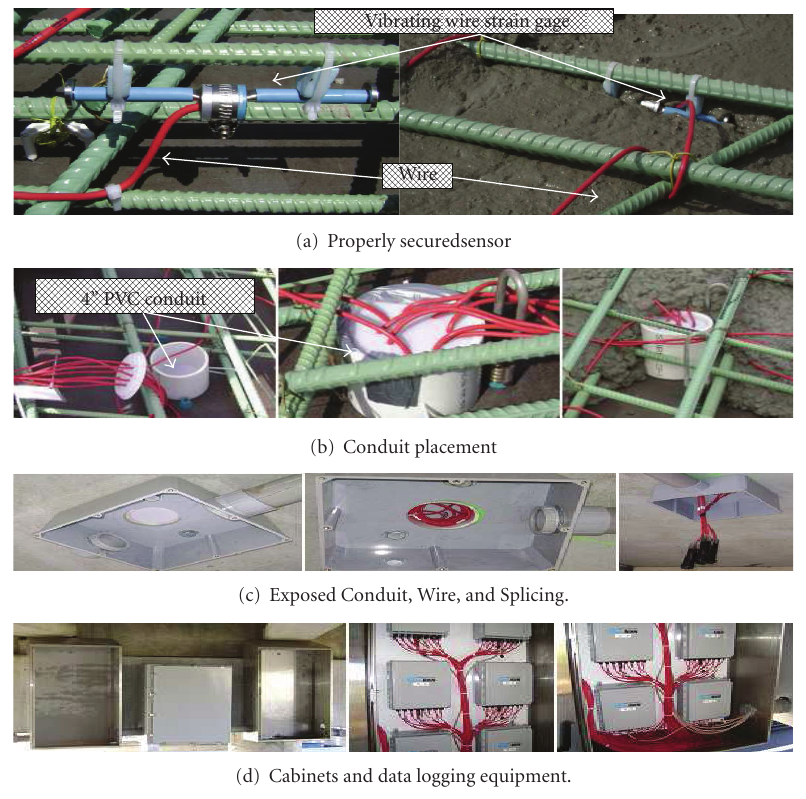
Figure 3: The components and wiring of the sensor network. Table 1: Health monitoring case study